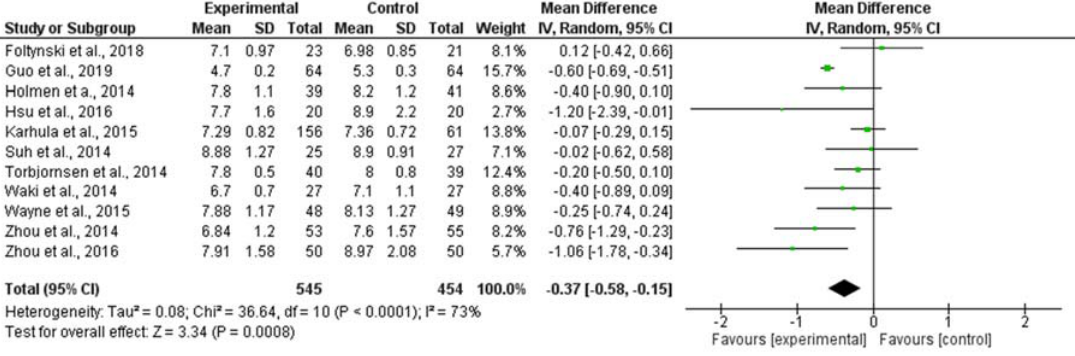
Figure 2. Comparison between intervention and control forestplot.